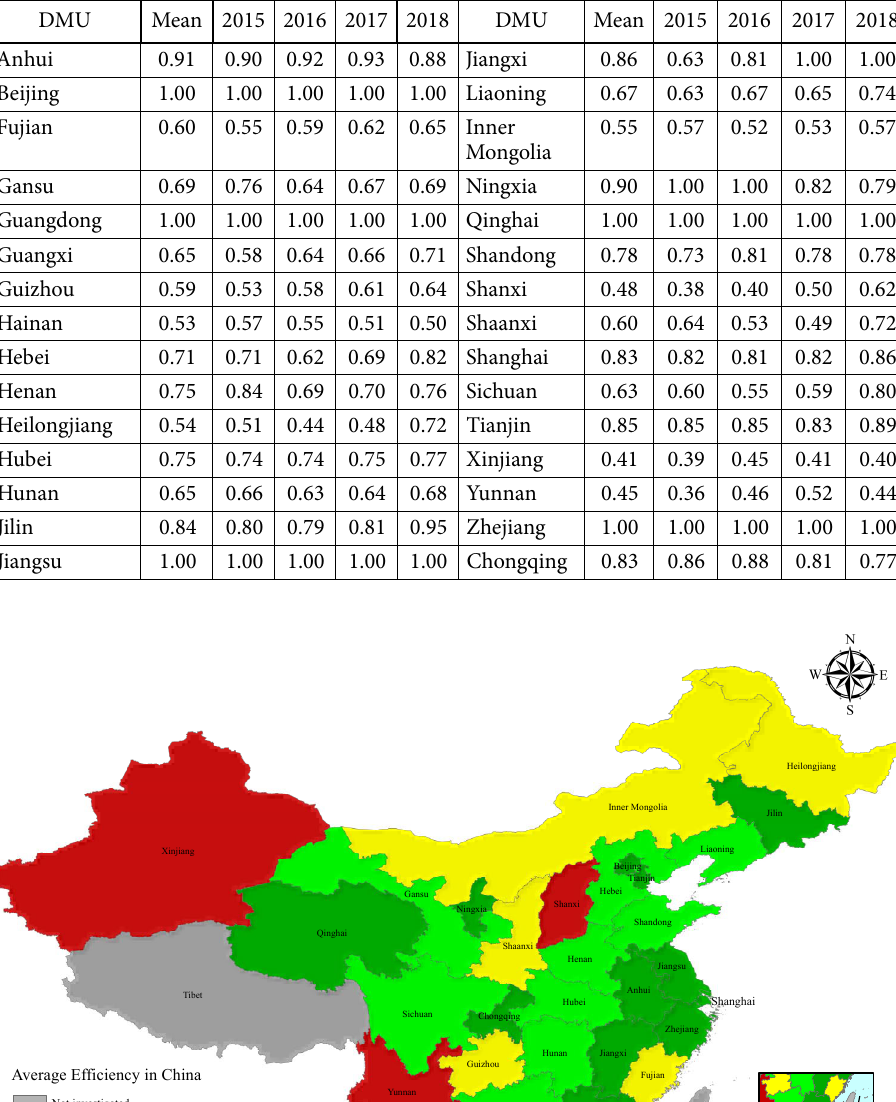
Table 4. Theoretical and application innovation efficiency in each province DMU